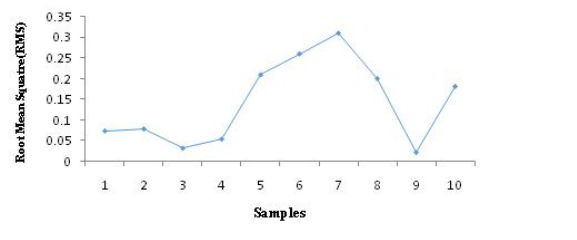
Figure 8: Root Mean Square (RMS) of the different samples